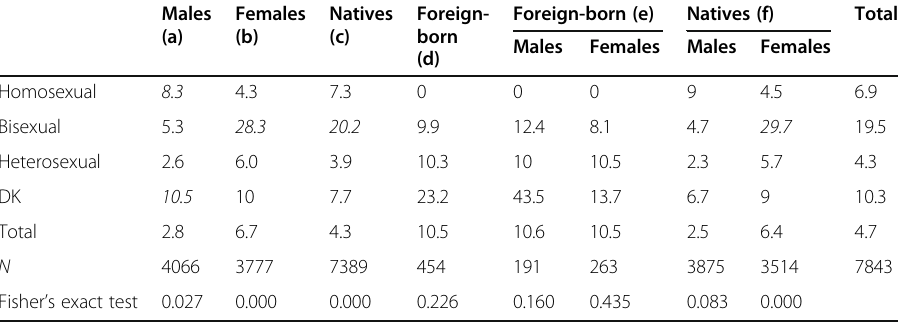
Fisher ’ s exact test